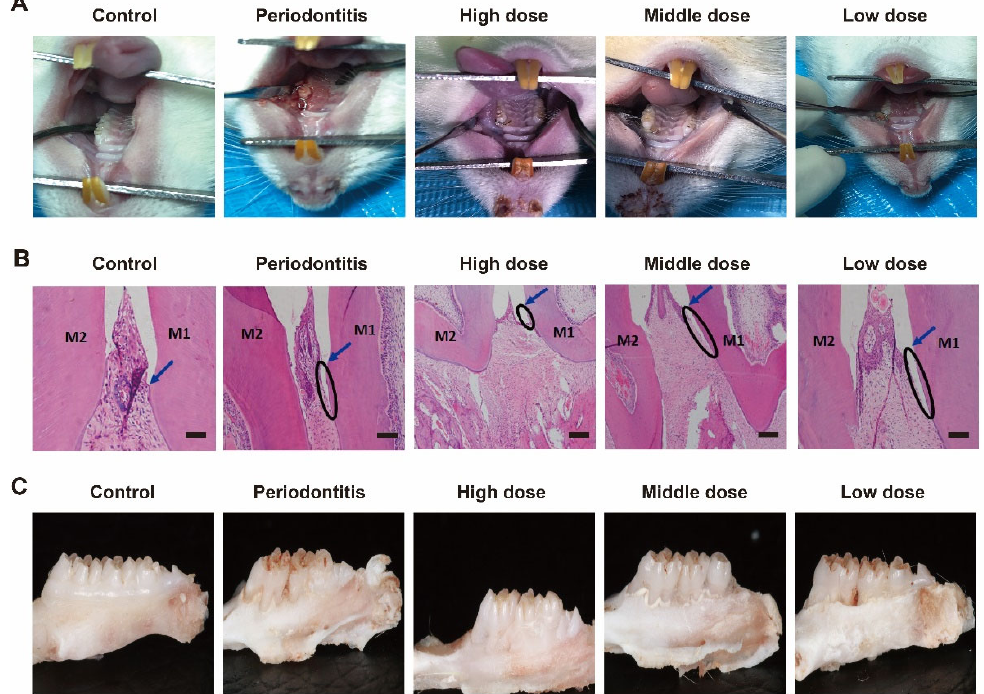
Figure 3. H&E staining and oral conditions of the periodontium 2 weeks after treatment. ( A ) Oral conditions of rats in different groups; ( B ) H&E staining. M1, the first molar; M2, the second molar; Arrow, cementum enamel; ellipse, attachment loss; bar = 100 µ m. ( C ) Morphological changes in the alveolar bone of rats in different